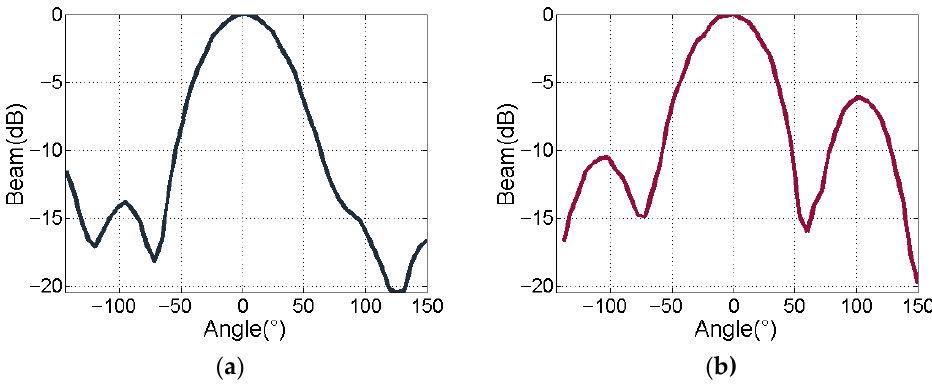
Figure 22. The directivity of transmitter. ( a ) Horizontal directivity; ( b ) Vertical directivity.